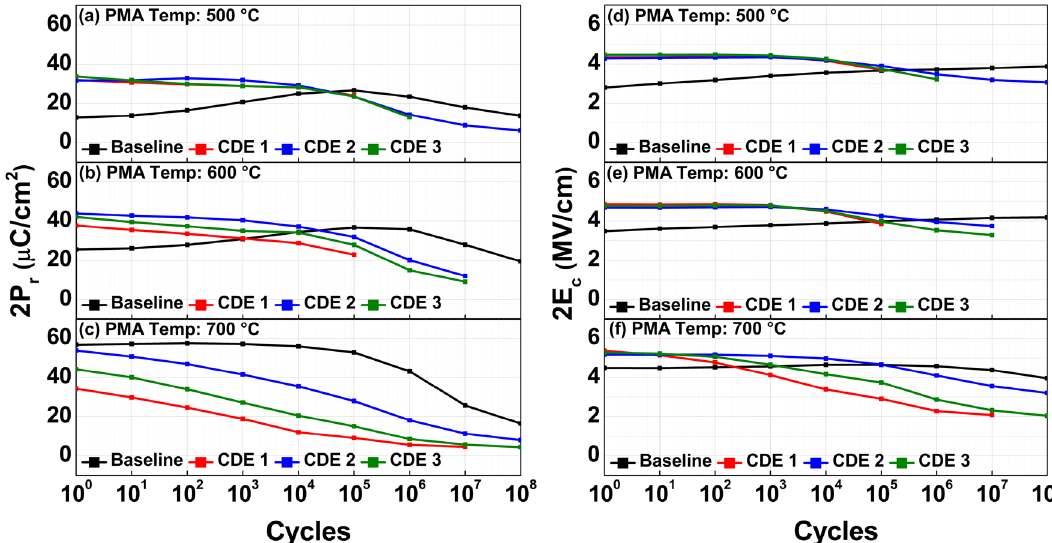
Figure 5. Measured 2P r vs. the number of cycles and 2E c vs. the number of cycles for endurance of the MFIS capacitors under three different PMA temperatures: ( a,d ) 500 °C, ( b,e ) 600 °C, and ( c,f ) 700 °C.